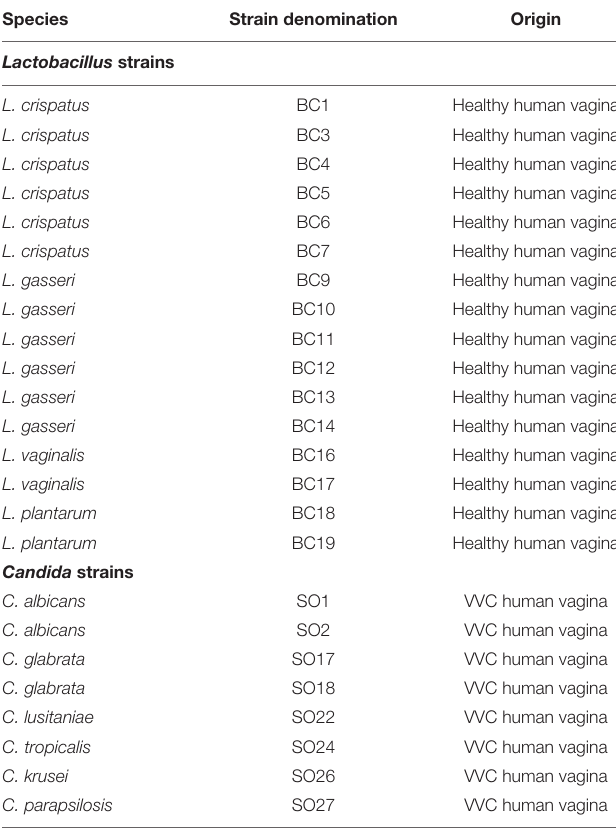
TABLE 1 | List of microorganisms used in the present manuscript and origin (VVC: vulvovaginal candidiasis). Species Strain denomination